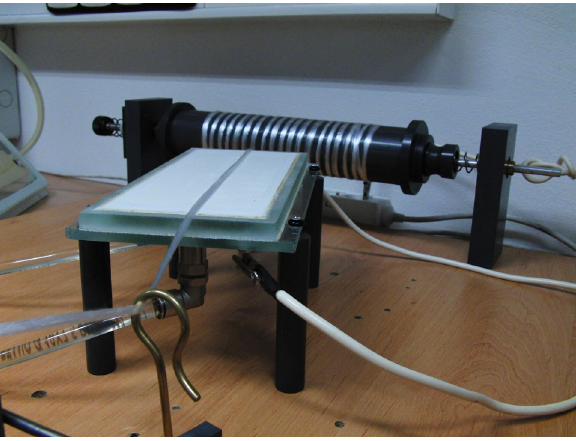
Figure 1: Schematic of the DCSBD setup for the treatment of PP fibres.